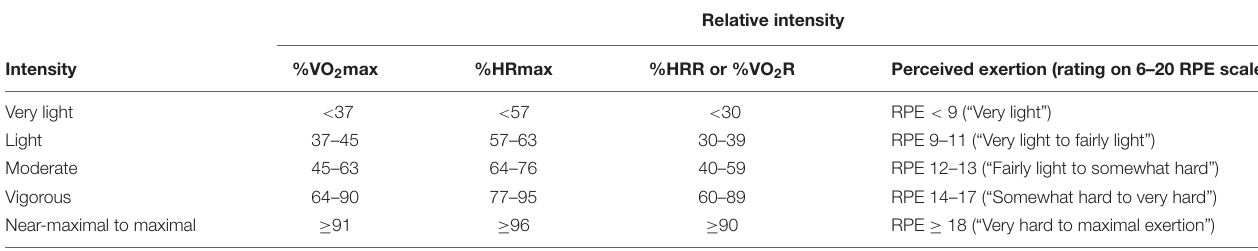
Table adapted from Garber et al. (2011) and American College of Sports Medicine (2018). VO 2 peak = maximal oxygen uptake; %VO 2 max = percent of maximal oxygen uptake; HRmax, maximal HR; = %HRmax = percent of maximal HR; HRR, HR reserve; VO 2 R, oxygen uptake reserve; RPE, ratings of perceived exertion (Borg,